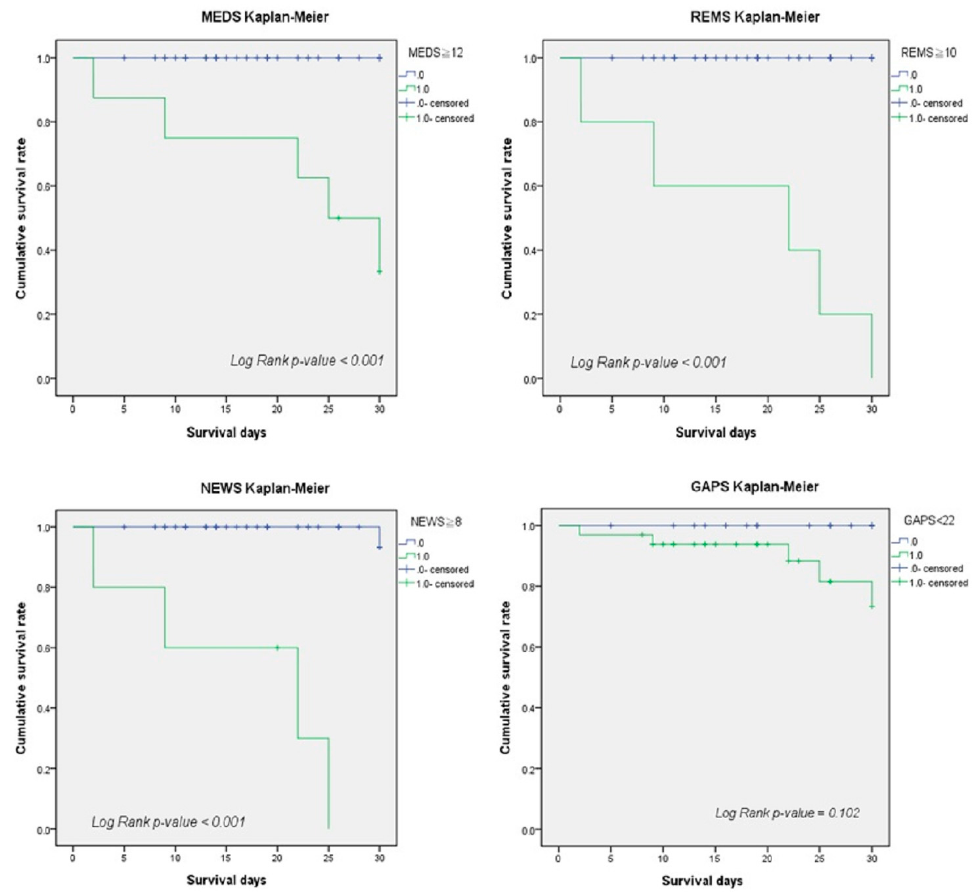
Figure 2. The cumulative survival rates of patients with EPN were calculated to predict the 30-day mortality rate by Kaplan–Meier analysis. The cut-off points of MEDS, REMS, NEWS, and GAPS were 12, 10, 8, and 22,